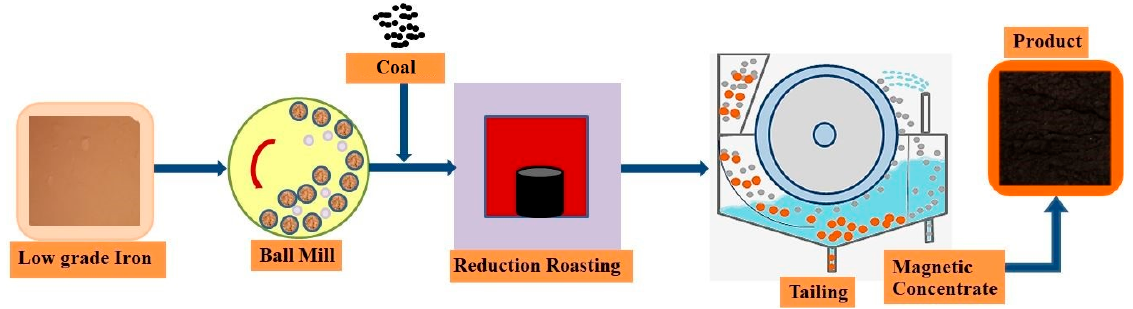
Figure 1. Step-by-step process of reduction roasting process.